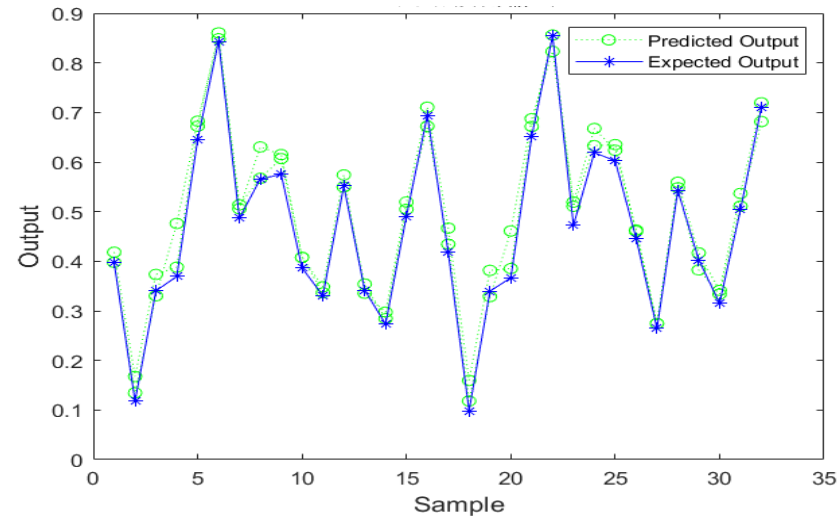
Figure 2. The predicted output of BP neural network.